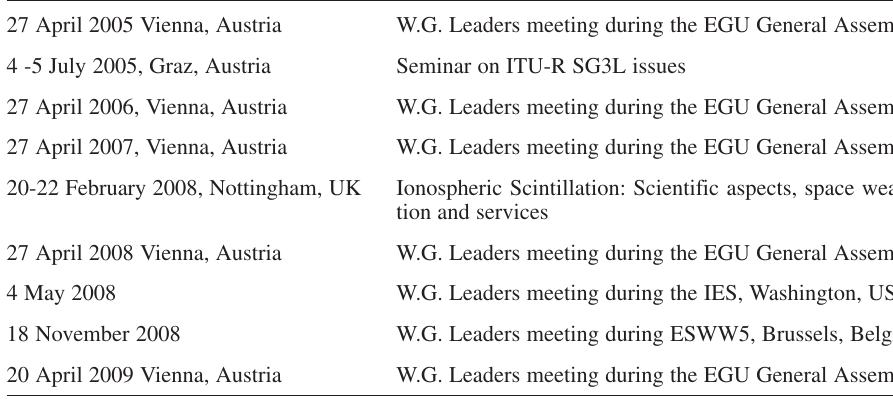
Table VIII. COST 296 Short-term Scientific Missions Sari M.O. (Middle East Technical University) to E.M. Warrington (University of Leicester), 16-20 January 2006. Kouba D. (IAP, Prague, CZ) to A. Belehaki (NOA, Athens, Greece) 19-26 March 2006. Romano V. (INGV Rome, Italy) to A. Bourdillon (University of Rennes, France) 9-16 May 2006. Krankowski A. (University of Warmia and Mazury, Krakow, Poland) to Manuel Hernandez-Pajares (Technical University of Catalonia, Barcelona, Spain) 25 June-3 July 2006.